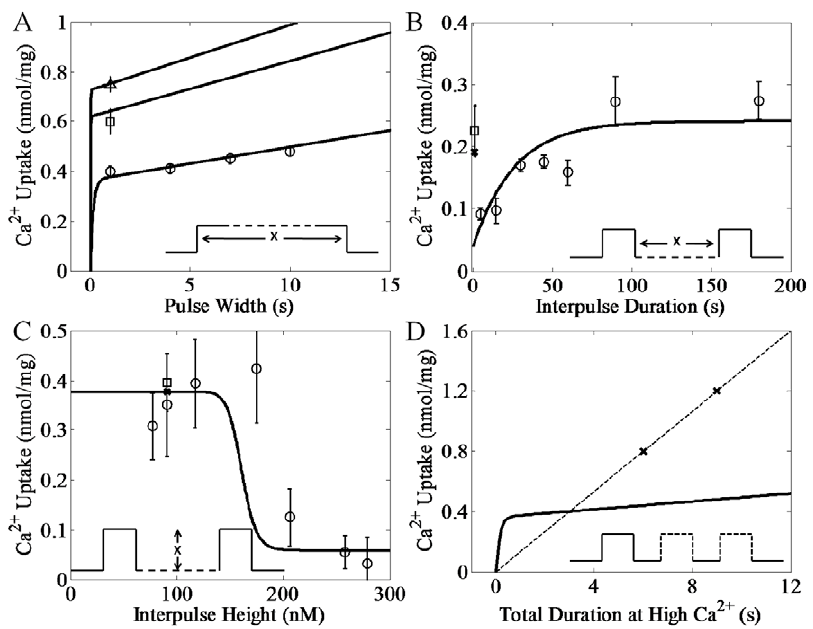
Figure 1. Simulations of the experimental data of Ca 2 + uptake facilitated by RaM in heart. The corresponding pulse waveform for each experiment is shown in each panel. A) The model reproduced the measured Ca 2 + uptake responses to pulses of Ca 2 + at varying pulse heights and durations. The circles represent the Ca 2 + uptake from a single pulse at a pulse height of 201 nM with an increasing pulse duration. The square and triangle represent the Ca 2 + uptake from a 1 s duration Ca 2 + pulse at a pulse height of 567 and 934 nM, respectively. The prepulse height for each pulse was 53 nM. B) The model reproduced the measured Ca 2 + uptake response to a second pulse of Ca 2 + following a previous pulse of the same magnitude at varying interpulse durations. The circles represent the Ca 2 + uptake from a second pulse immediately after and up to 180 s after the first pulse. Both pulses were 5 s in duration at a pulse height of 209 nM with an interpulse height of 98 nM. The square represents a single, 5 s pulse at a pulse height of 181 nM with a prepulse height of 86 nM. C) The model reproduced the measured Ca 2 + uptake response to a second pulse of Ca 2 + following a previous pulse of the same magnitude at varying interpulse heights at a fixed interpulse duration of 60 s. Each pulse duration was 5 s. The circles represent the Ca 2 + uptake from the second pulse at a pulse height of 274 nM. The square represents a single pulse at a pulse height of 273 nM for a duration of 5 s. D) The model reproduced the enhanced Ca 2 + uptake response to multiple, short pulses versus a single, long pulse. The dashed line follows the trend of increasing Ca 2 + uptake for in an increasing the number of pulses. All simulation results are either shown as x’s or a solid line depending on the nature of the simulation.